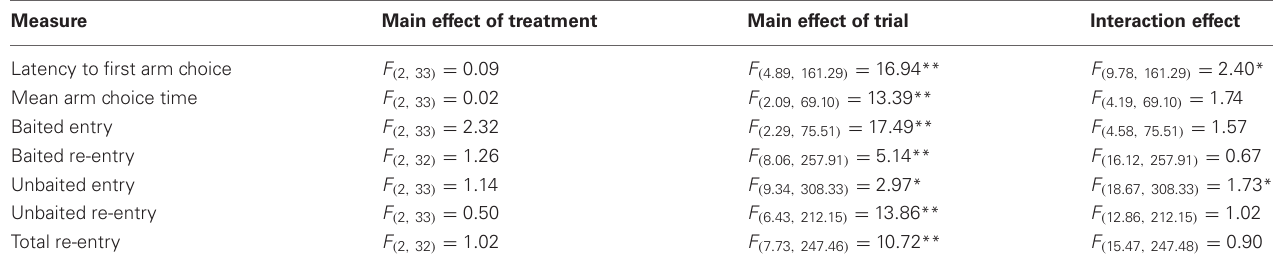
Table 1 | Results of 1 within (TRIAL), 1 between (TREATMENT) ANOVA on the